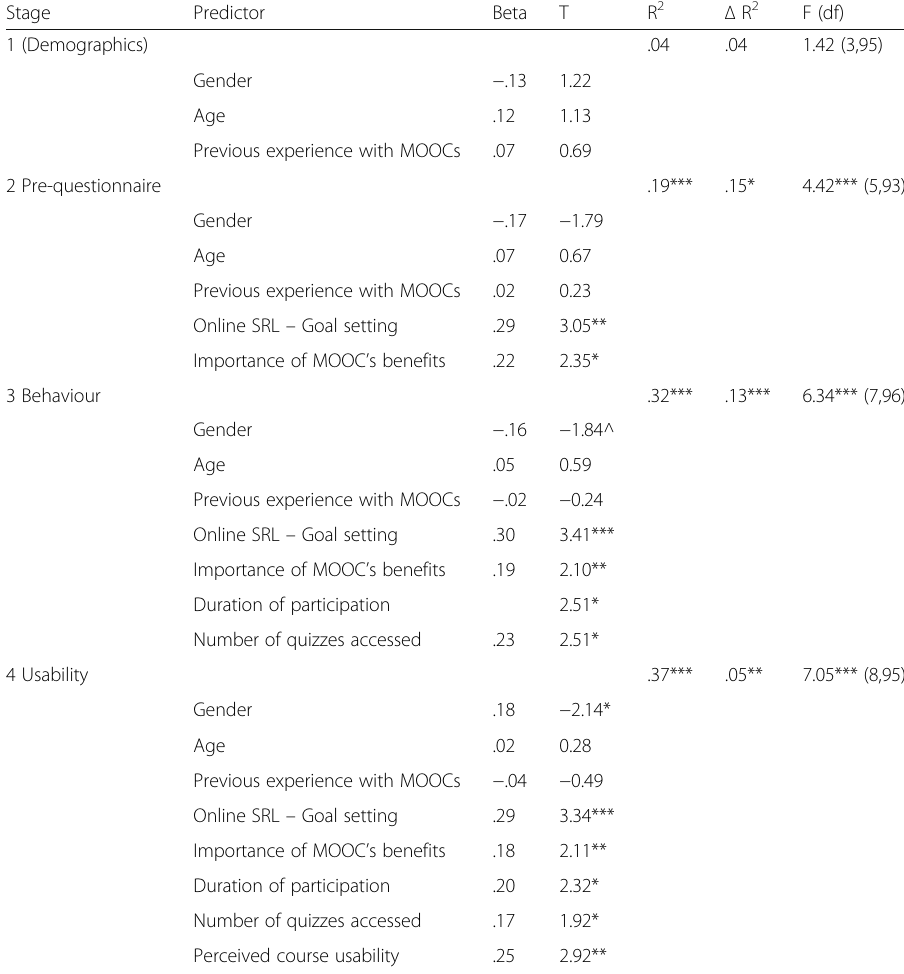
Table 3 Stepwise linear regression predicting intention-fulfillment, performed in four stages Stage Predictor Beta T R 2 Δ R 2 F